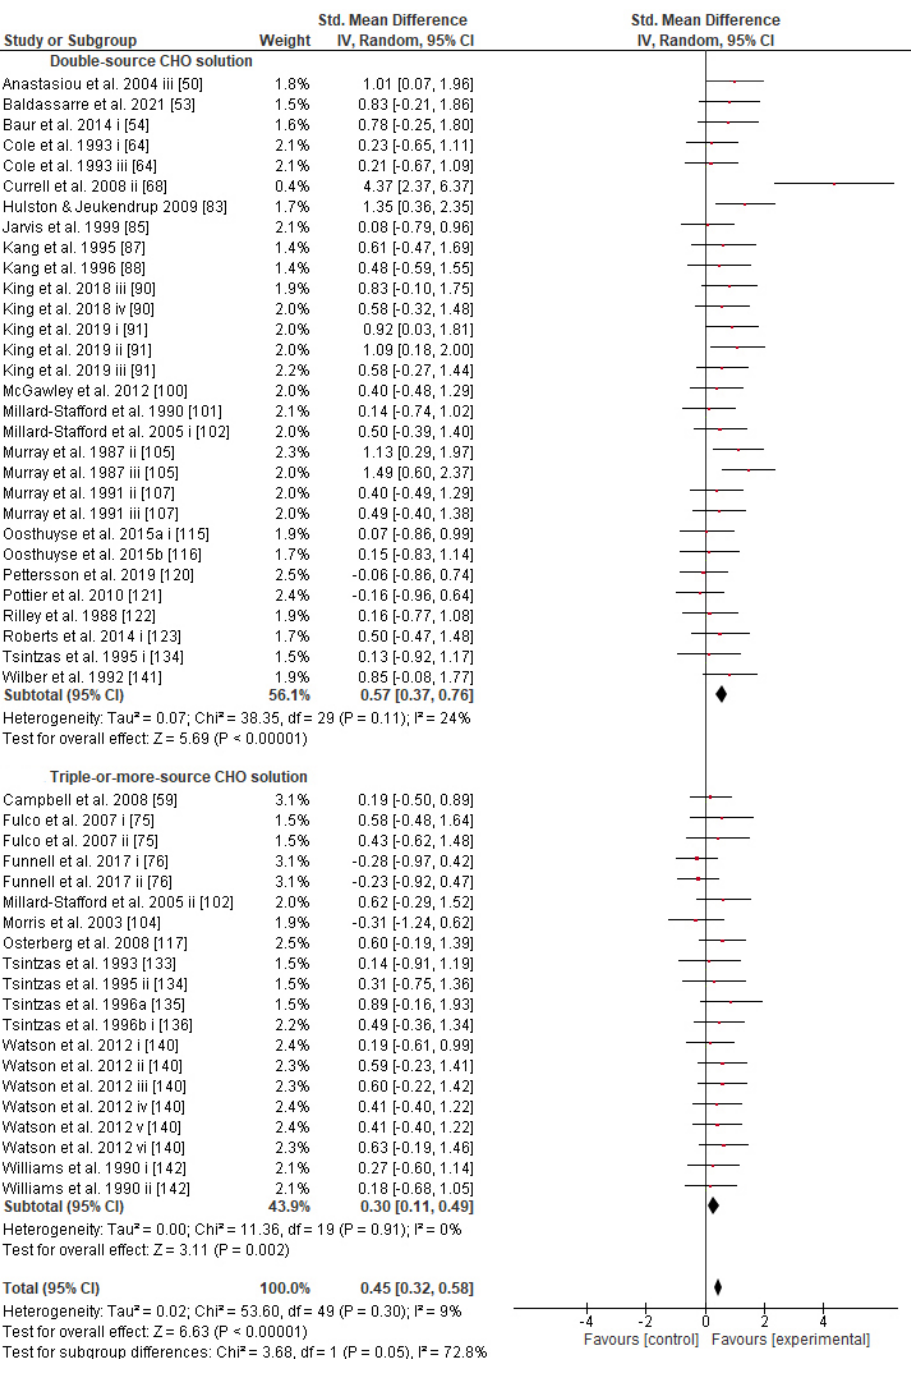
Figure 6. Forest plot shows the effects (red square symbol) of experimental carbohydrate supplementation as compared to a control on exercise outcome for 50 interventions [49,52,53,58,63,67,74,75,82,84,86,87,89,90,99–104,106,114–116,119–122,132–135,139–141]. Subgroup analyses show the results with regards to supplementation in two carbohydrate formulation groups (double-source CHO solution, triple-or-more-source CHO solution). The black diamond symbol at the subgroups and at the bottom of the figure represents the standardized mean difference with the 95% confidence intervals for all interventions following random effects meta-analyses. Studies or trials that provided insufficient data for subgroup classification were not included. Abbrevia- tions: CHO, carbohydrate; CI, confidence interval; IV, inverse variance; SD, standard deviation; Std, standardized; i–vi denote different intervention arms (trials) within the same study.